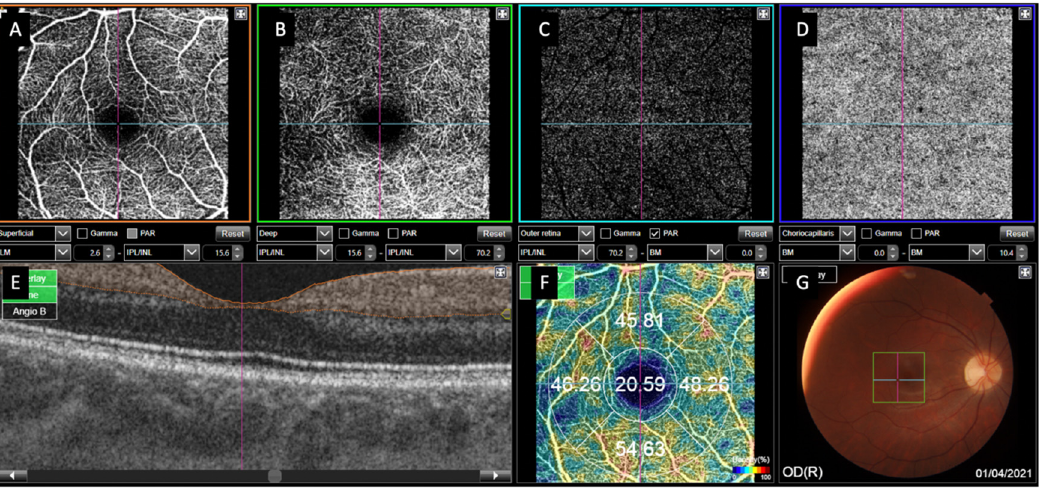
Figure 1. Image of 3 × 3 mm optical coherence tomography angiography (OCTA) performed by Deep-Range Imaging (DRI)-Triton SS-OCT device. ( A ) Retinal superficial capillary plexus (SCP). ( B ) Retinal deep capillary plexus (DCP). ( C ) Outer retina. ( D ) Choriocapillaris plexus (CC). ( E ) OCT profile (in orange the area in which SCP vessel density (VD) is studied). ( F ) Vessel density at the SCP as the percentage of pixels occupied by blood flow in the central area and in the 4 quadrants. ( G ) Fundus photography showing the examined OCTA area as a square in the central area.